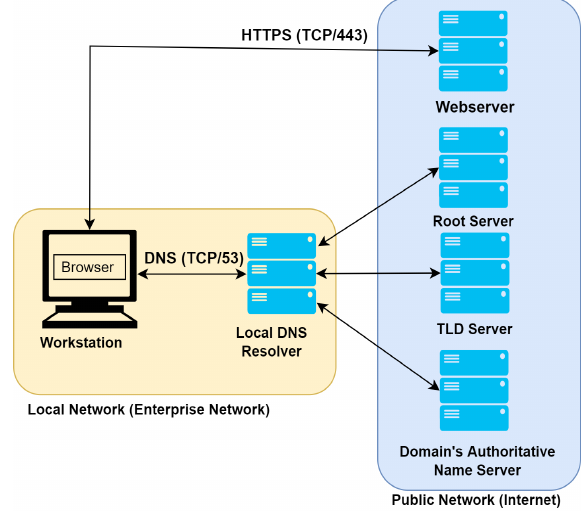
Figure 1. DNS resolution process.